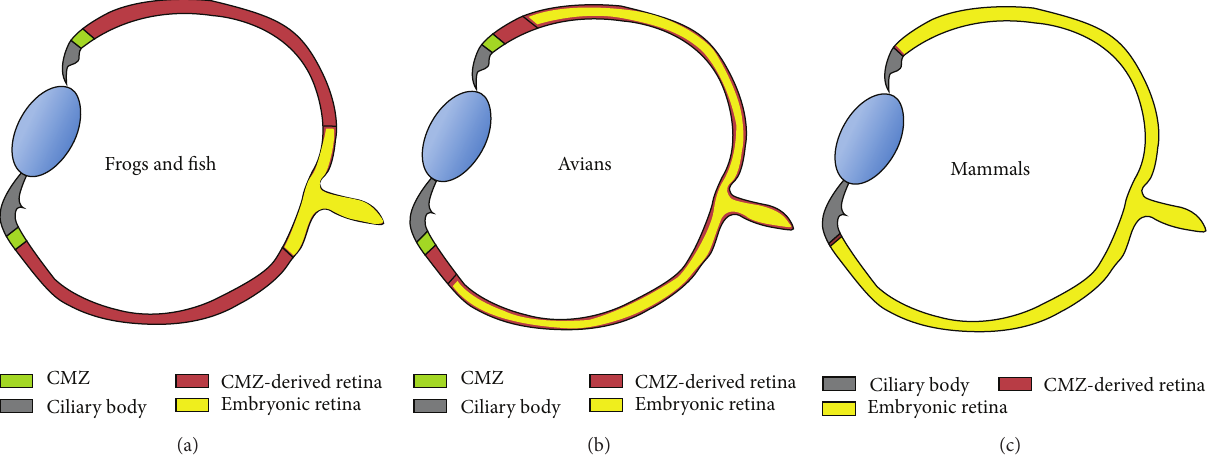
Figure 2: CMZ in vertebrates. The CMZ is progressively reduced in higher vertebrates. The adult eye of different vertebrates (frogs and fish (a), avians (b), and mammals (c)) is shown in blue and represents the neural retina of embryonic origin, which lacks the continuous renewal ability of the CMZ, which is shown in yellow. CMZ: ciliary marginal zone. Copyright 2004. Modified with permission from UBC Press [27].